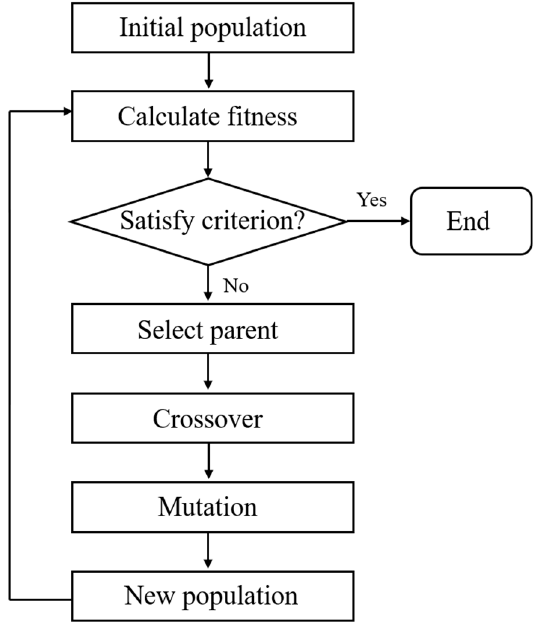
Figure 9. Optimization flow of genetic algorithm.